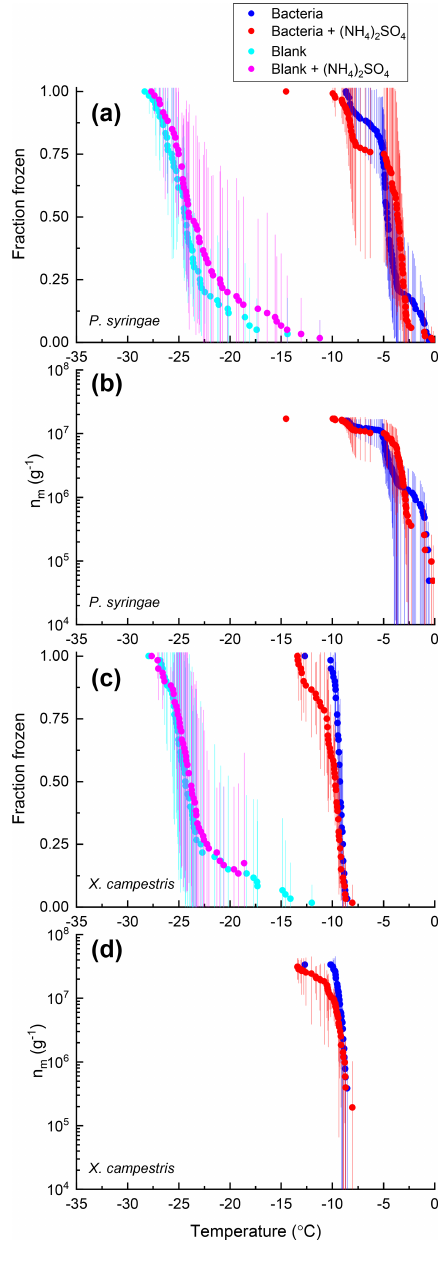
Figure 3. Fraction of droplets frozen (a, c) and ice nucleation active site densities n m (T ) (b, d) for samples of P. syringae (a, b) and X. campestris (c, d) with (red) and without (blue) 0.05M(NH 4 ) 2 SO 4 compared with the respective growth media blank with (pink) and without (cyan) 0.05M(NH 4 ) 2 SO 4 . Freezing data (both samples and blanks) have been corrected for freezing point depression by 0.05M(NH 4 ) 2 SO 4 . Error bars represent the 95% confidence inter- val of fraction frozen or n m (T ) at temperature T calculated using Student’s t distribution. For P. syringae , 2 drops out of 120 froze close to the blanks, which is inconsistent with previous studies re- ported in the literature. We assume the low freezing temperature of these two droplets is because these two drops did not contain any cells. Hence, we removed these two data points from our